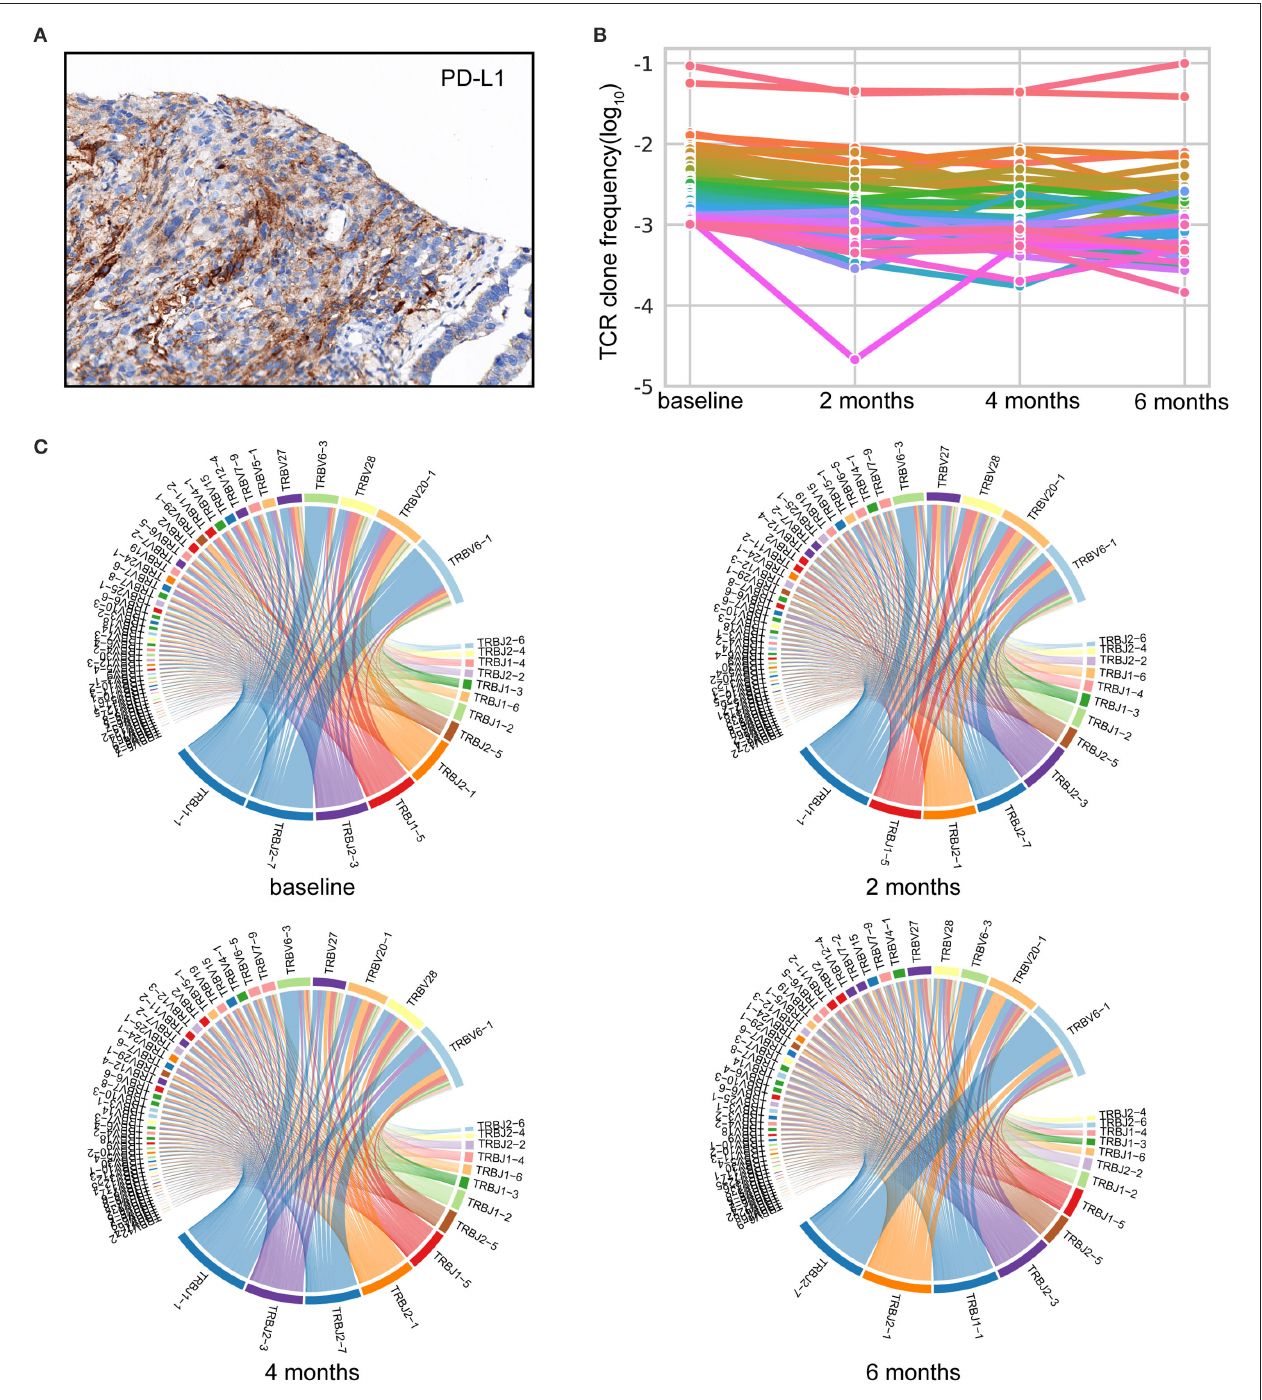
FIGURE 2 | Comprehensive analysis of the immune landscape. (A) Immunohistochemistry (IHC) image with anti-programmed cell death-ligand 1 (PD-L1) antibody (Dako IHC 22C3 platform). Microscope magnification 400 × . A PD-L1 tumor proportion score (TPS) of ≥ 50% was detected. (B) Maintenance of the high-frequency T-cell clones throughout Nivolumab treatment. TCR-seq was conducted on PBMCs collected pre and post Nivolumab treatment. T-cell clones with a frequency of ≥ 10 − 3 in the baseline are shown. Each line represents one clone. (C) Representative TRBV–TRBJ junction circos plots. Bands represent different V and J gene segments. Ribbons imply V/J pairings. The width of the band is proportional to the usage frequency.